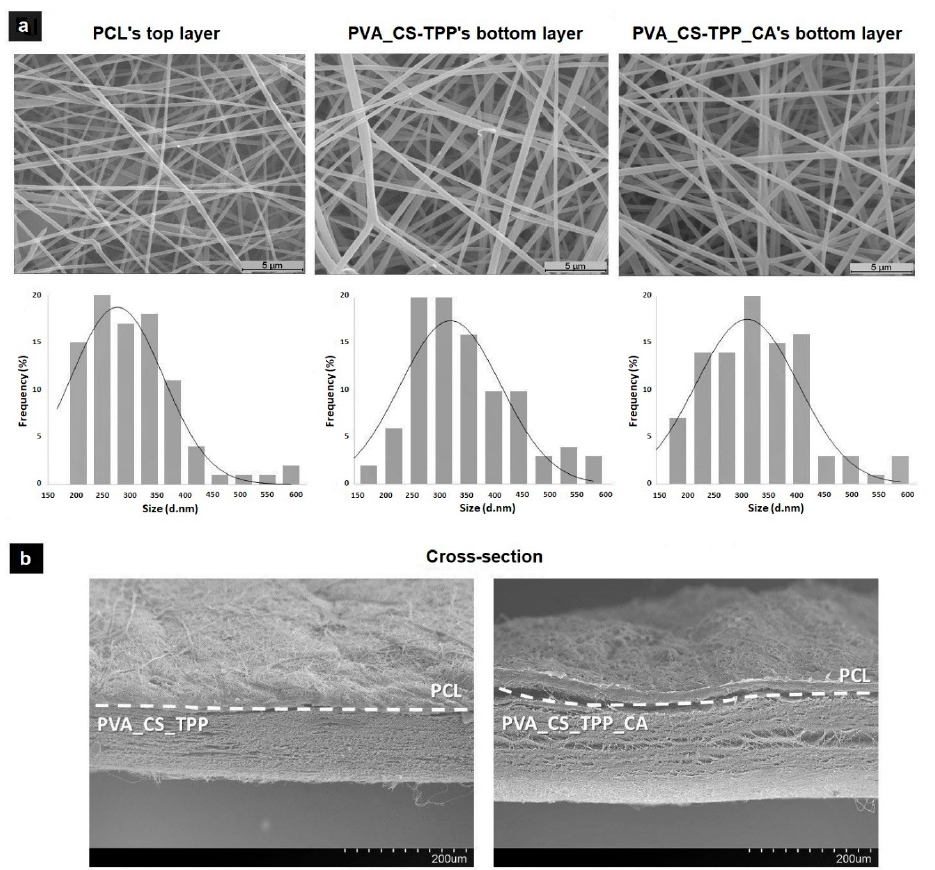
Figure 1. Morphology and fiber diameter distribution of the Polycaprolactone (PCL)’s top layer and the Poly(vinyl alcohol) (PVA) and Chitosan-Sodium tripolyphosphate (CS-TPP) (PVA_CS-TPP) and PVA_CS-TPP containing Centella asiatica (L.) (CA)’s bottom layers ( a ); and cross-sectional SEM images of the double-layered membranes; ( b ) PCL / PVA_CS-TPP with crude CA extract (on the right) and without (on the